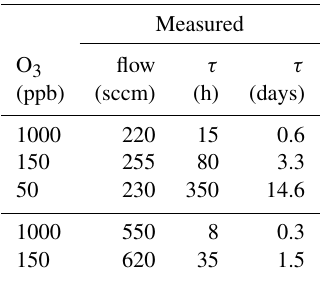
Figure 13. Measured data from the scrubber endurance test. Table 3. Ozone mixing ratio and corresponding flows through the scrubber during scrubber endurance tests, as well as resulting life- times τ .